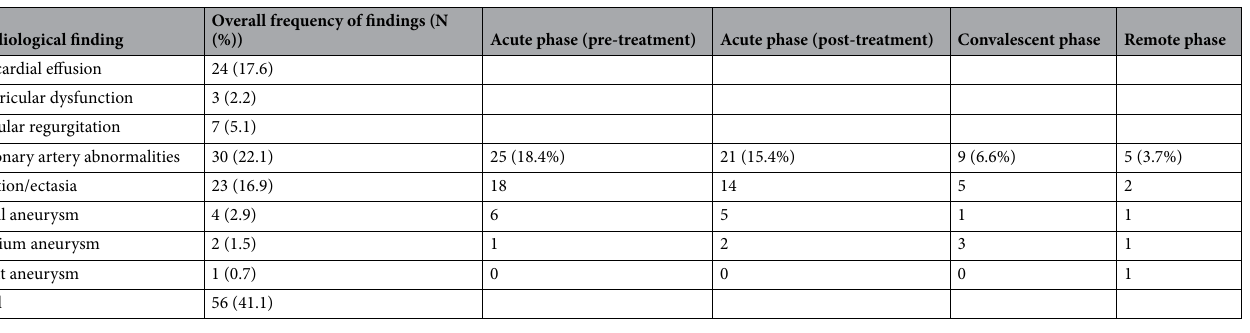
Table 3. Cardiological findings in patients with